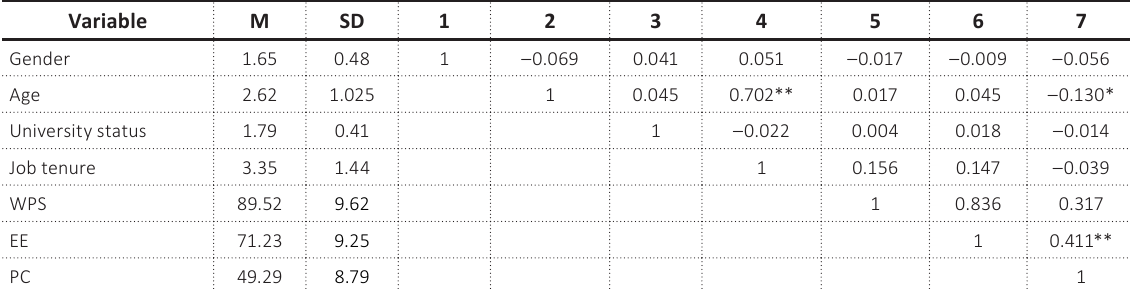
Tabel 4. Hypothesis testing results